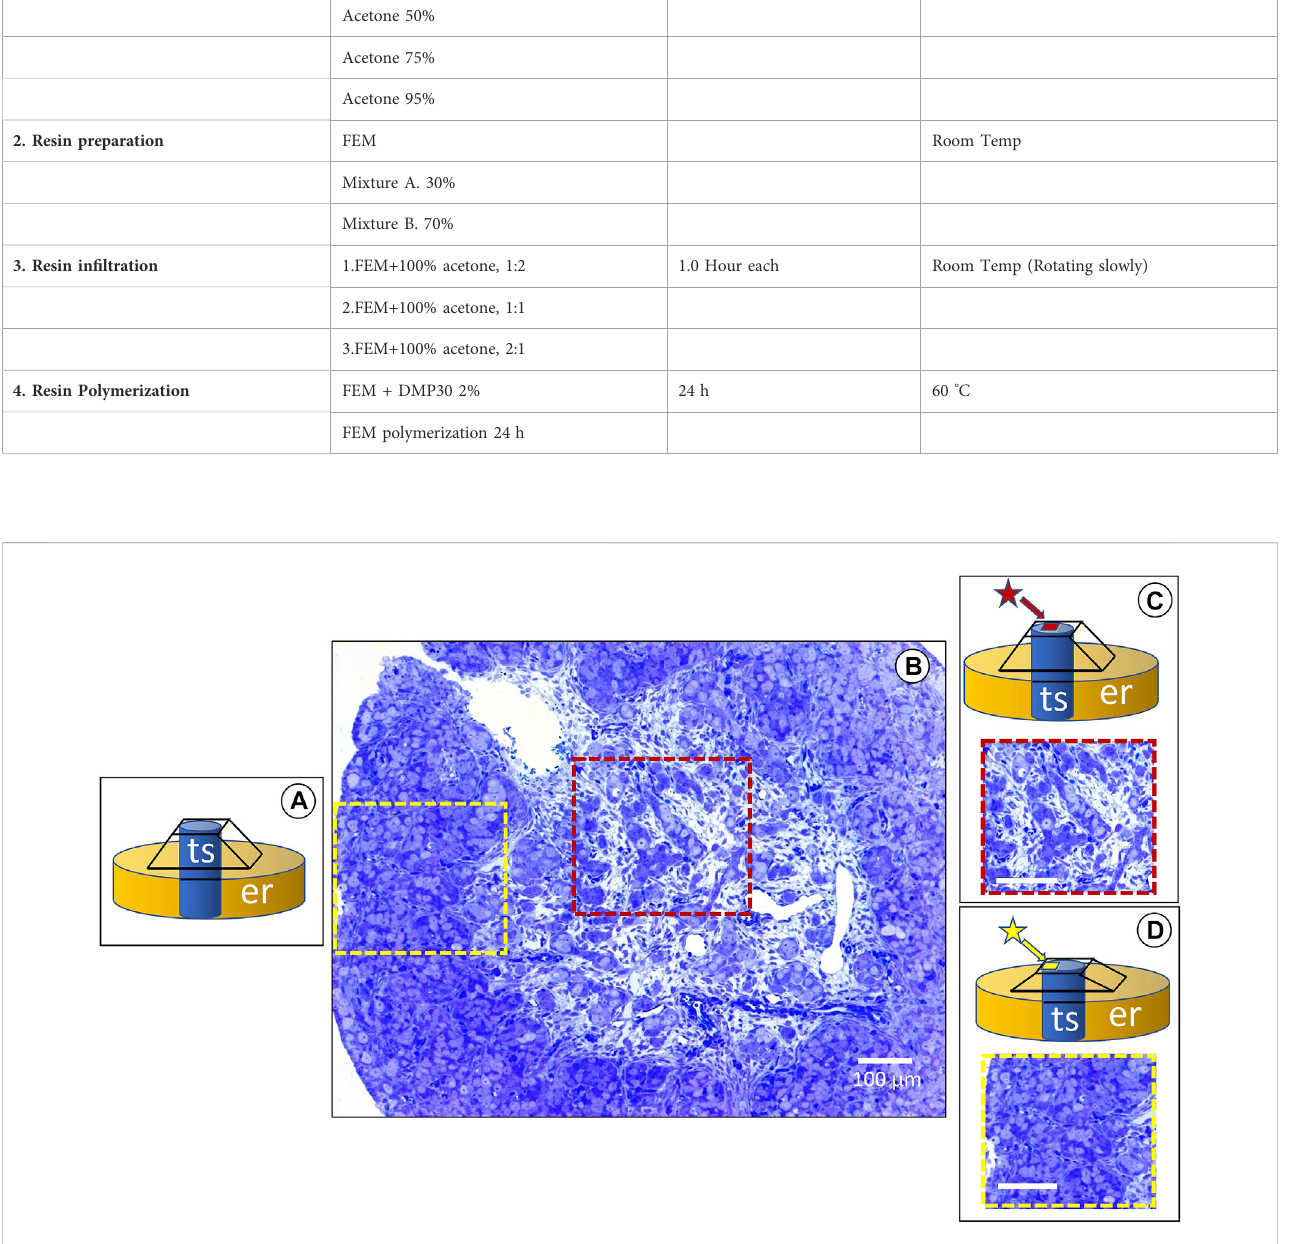
FIGURE 1 The red and yellow dashed squares show the medullary and cortical regions consecutively, analyzed by light and FIB-SEM. The insets (A – D) are schematicrepresentationsoftheserialtrimmingprocedure: (A) thetissuesample(ts)embeddedintheresin(er)afterapyramidwasformedfromarazorblade on the top of the block. (B) Cross section of a developing rabbit ovary at 25 days (dpp) postpartum, stained with toluidine blue. The histological differences between the medullary and cortical regions are evident. The former has abundant loose stromal tissue around the ovigerous cords, whereas the latter shows a compact structure. (C) A square around 1.0 mm high (red star) is manually constructed on top of the truncated pyramid, in order to make serial semithin sections for 3D reconstruction of the medullary region. Under the light microscope. (D) Once an area of interest is found in the medulla, a similar procedure is performed on the ovarian cortex (yellow star), in order to analyze diverse regions of the ovary as relates to the FIB-SEM cycles of semithin serial sections and then undertake stepwise trimming at the